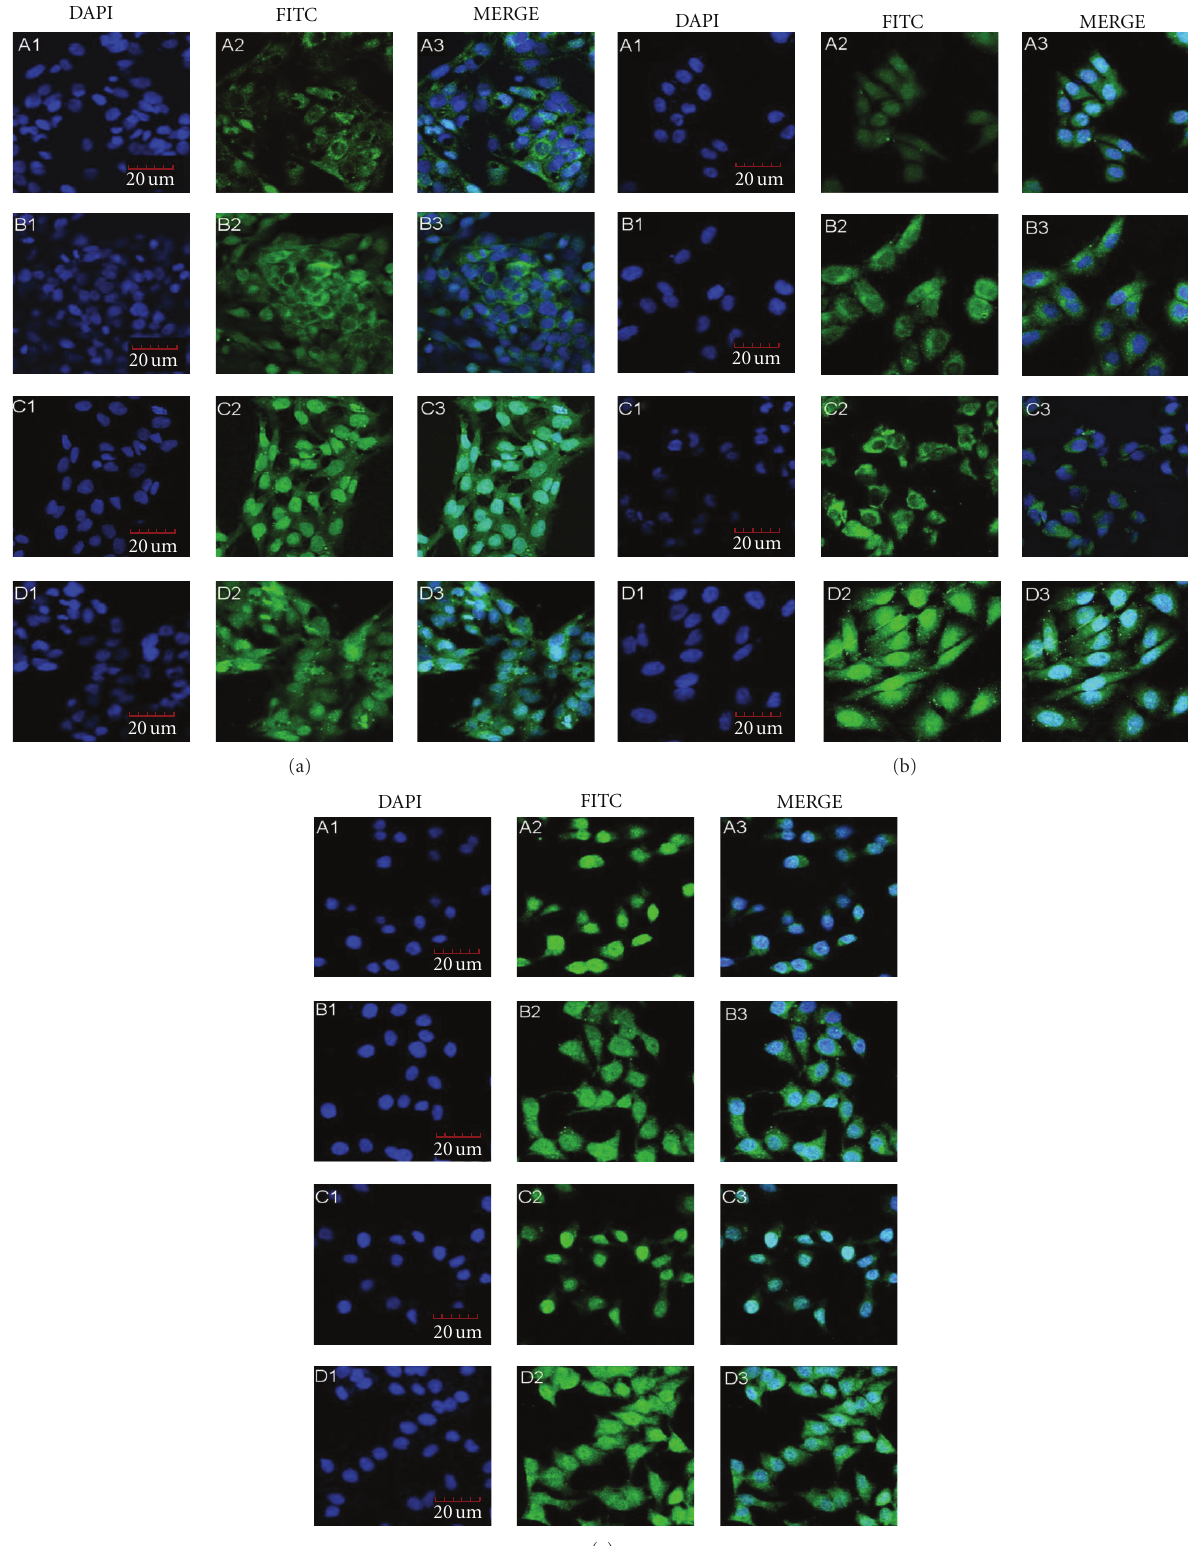
Figure 1: Localization of TCTP in HepG2 cells (a), HL-7702 cells (b) and HeLa cells (c), A1–A3: 12 h, × 400; B1–B3: 24 h, × 400; C1– C3:48h, × 400; D1–D3: 60h, ×